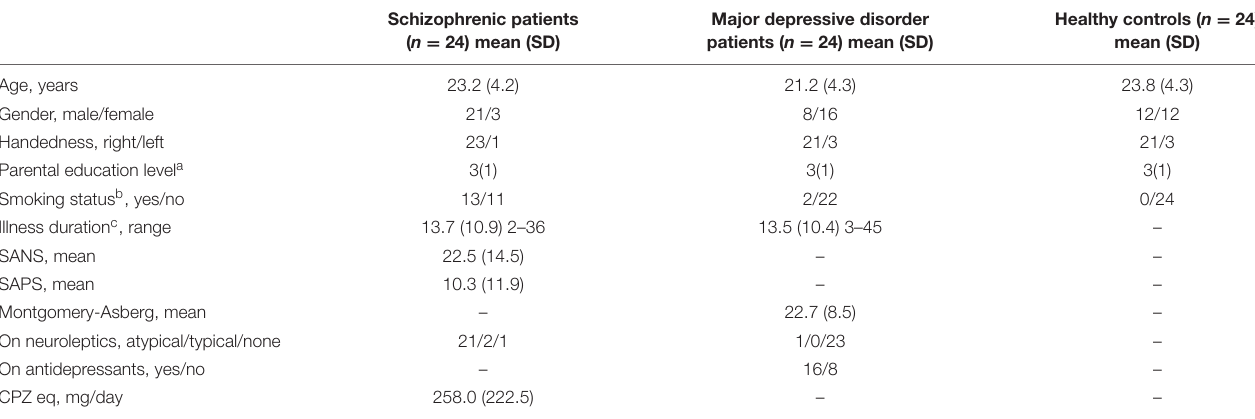
TABLE 1 | Participant demographic